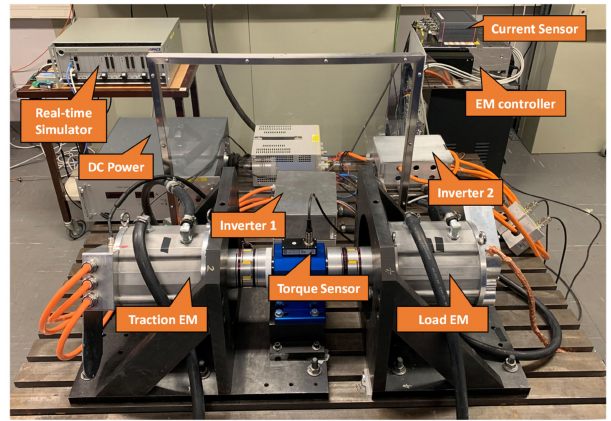
Figure 13. Experimental setup of back-to-back electric machine test bench.